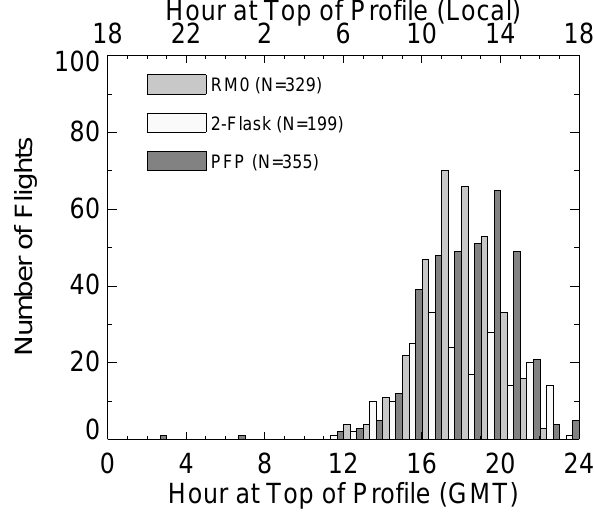
Fig. 2. Frequency histogram of hour at which highest altitude sam- pling took place, sorted by sampling